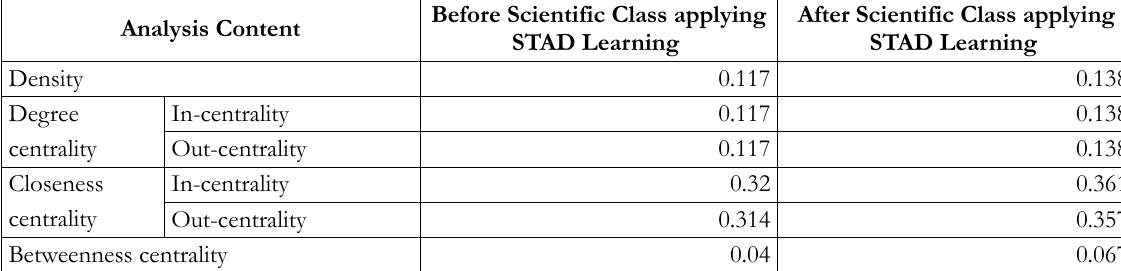
Table 6. Analysis Result of Social Network